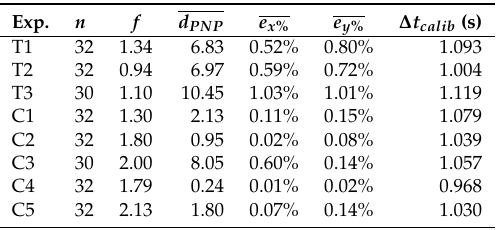
Table 2. Perspective-n-Point and calibration